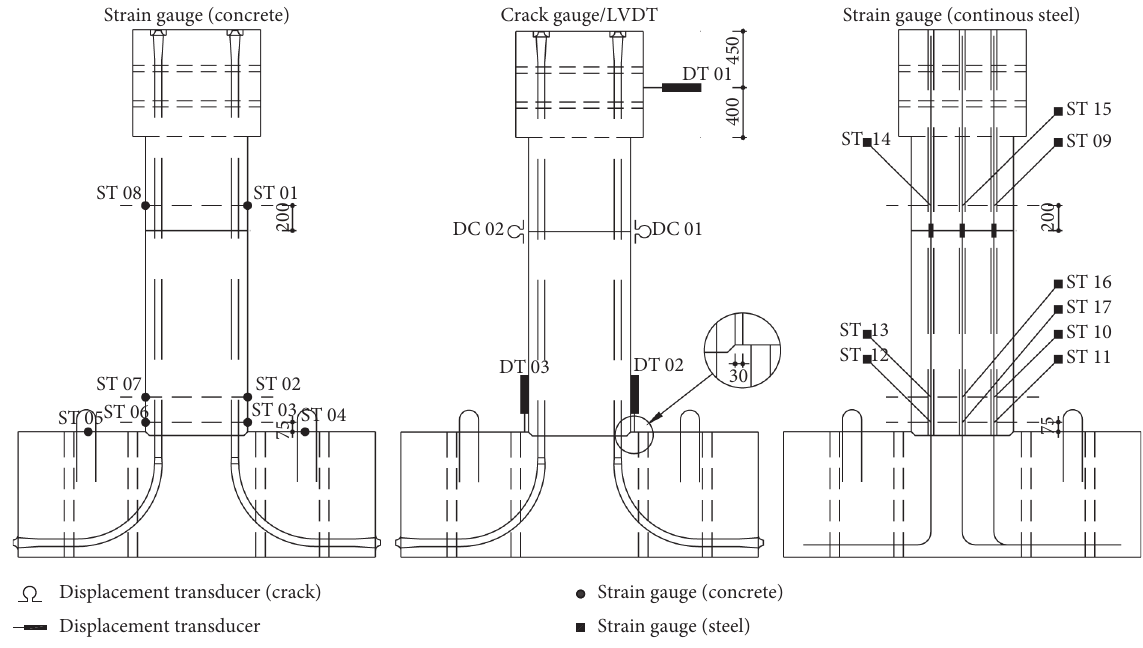
Figure 4: Measurement (unit: mm).